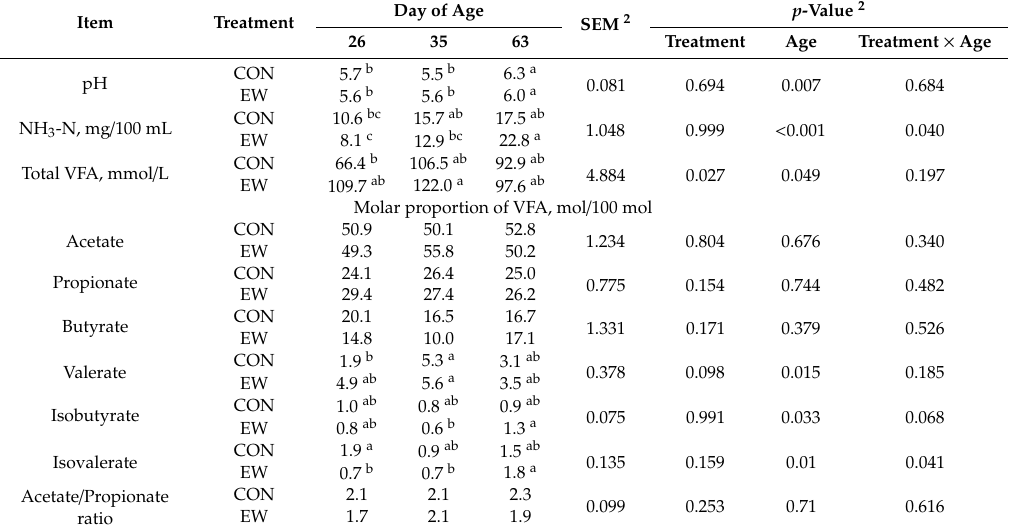
Table 3. Rumen pH, ammonia nitrogen (NH 3 -N), and volatile fatty acid (VFA) profiles of lambs at 26, 35, and 63 days of age 1